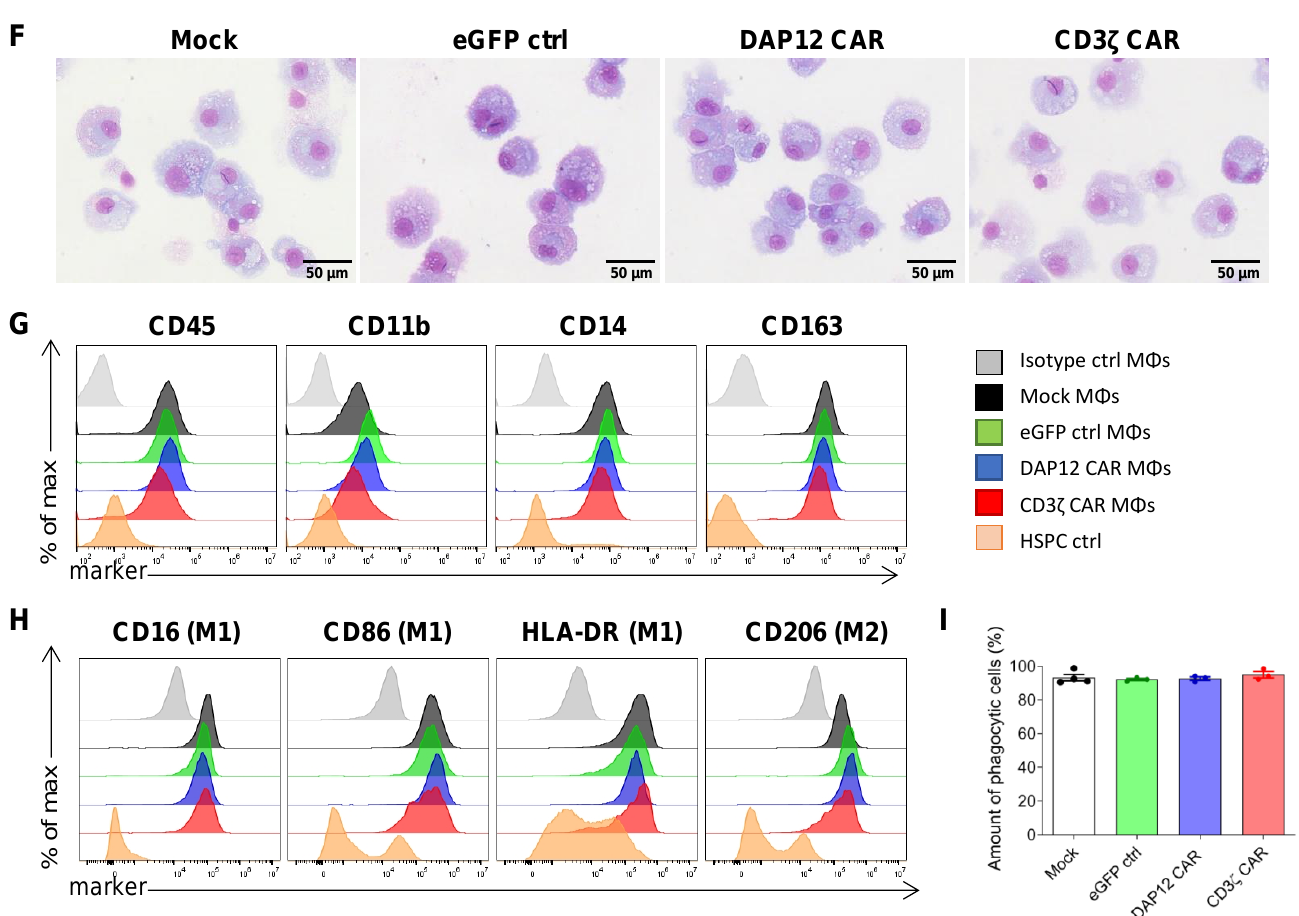
Figure 3. Generation and characterization of cord blood-derived anti-CEA CAR M Φ s. ( A ) Overview of the CAR M Φ generation protocol showing the cord blood CD34 + cell isolation, transduction with CAR constructs, and differentiation into M Φ s (created with BioRender.com). Numbers of ( B ) eGFP + sorted CB-derived CD34 + cells and ( C ) differentiated M Φ s obtained. ( D ) Expansion factor during differentiation of CB-derived CD34 + cells to M Φ s. Cells were counted after sorting and at the end of the differentiation using a Neubauer chamber ( n = 5). ( E ) Flow cytometric analyses of eGFP and CAR expression (as detected by the extracellular IgG CAR domain) in differentiated M Φ s. Plots are shown for a representative out of 4 experiments. ( F ) Microscopic analysis of M Φ morphology in May–Grünwald-stained cytospins (40 × magnification using the fluorescence microscope